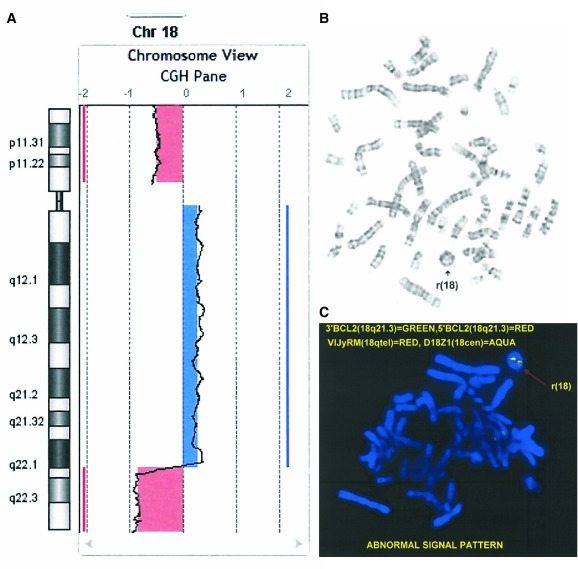

A. CGH panel illustrates deletions on distal arms (red) and duplication of proximal long arm (blue).
B. Karyotype in metaphase showing a ringed chromosome 18.
C. FISH analysis showing a ringed chromosome 18.